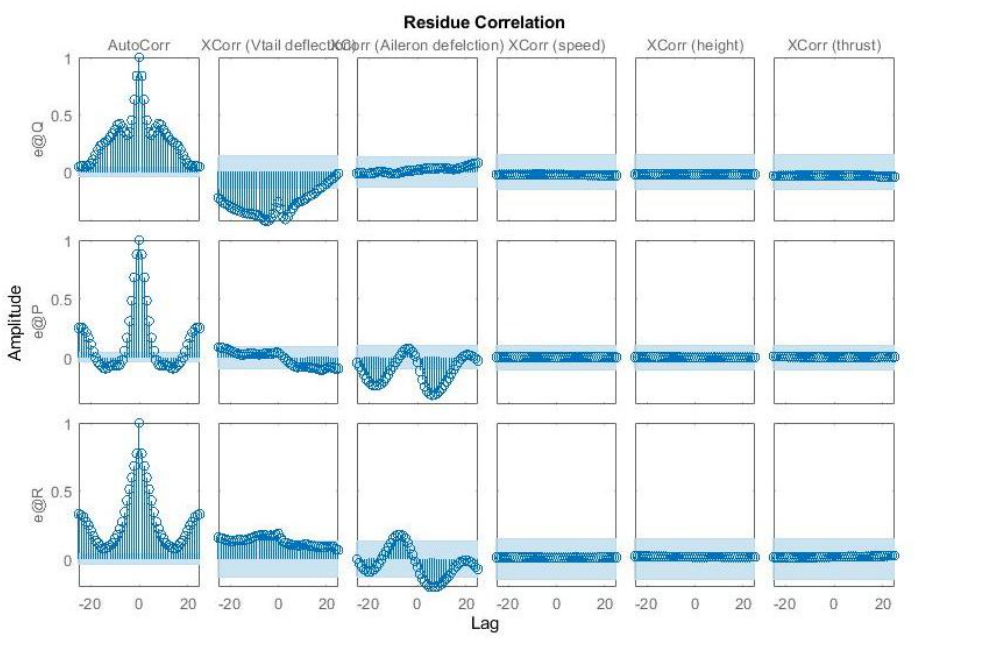
Figure 21. Tree Partition Residue Correlation.